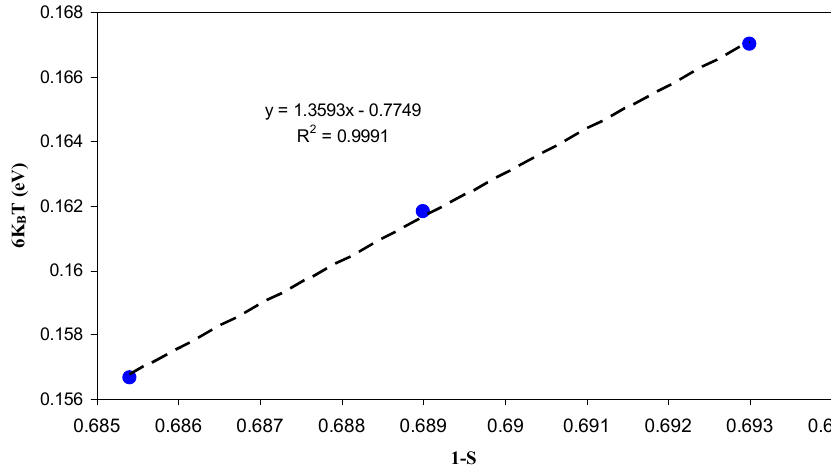
Figure 10. The plot of 6 K B T versus 1 − S or temperature ranges from 303 to 323 K. The W m value is 1.359 eV which is higher than the activation energy ( E a ≈ 0.1 eV) for this temperature range and thus ion transport occurs through the quantum mechanical tunneling (QMT).